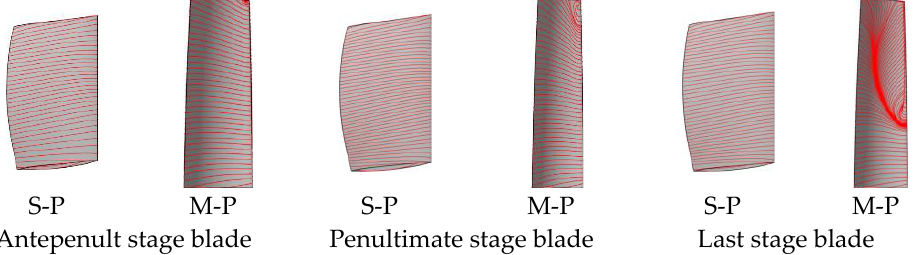
Figure 4. Limiting streamlines of the pressure surface on the last three stage blades of the HP cylinder (3.4 MPa back pressure, 60% load ratio).